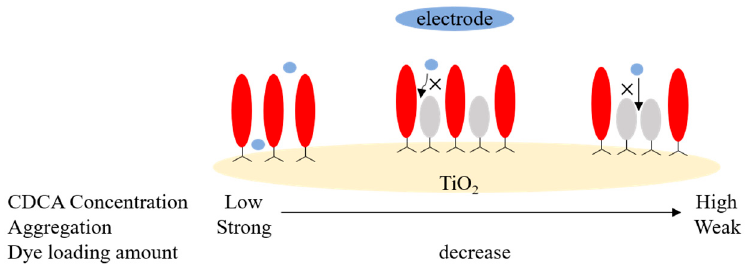
Figure 8. Diagram of the effect of co-adsorbent on dye aggregation.